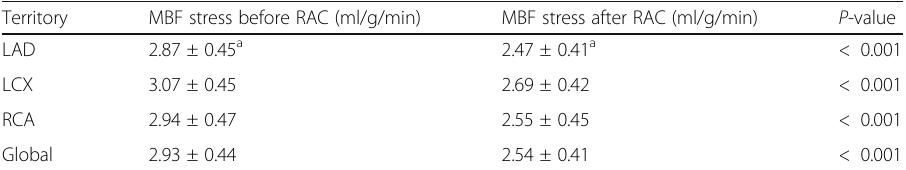
Table 4 Mean Myocardial Blood Flow before and after residual activity correction divided by territory Territory MBF stress before RAC (ml/g/min) MBF stress after RAC (ml/g/min) P -value LAD 2.87 ± 0.45 a LCX RCA Global Mean results ± standard deviation MBF Myocardial Blood Flow, RAC Residual Activity Correction, LAD Left Anterior Descending, LCX Left Circumflex, RCA Right Coronary Artery a not normally distributed by Shapiro-Wilk